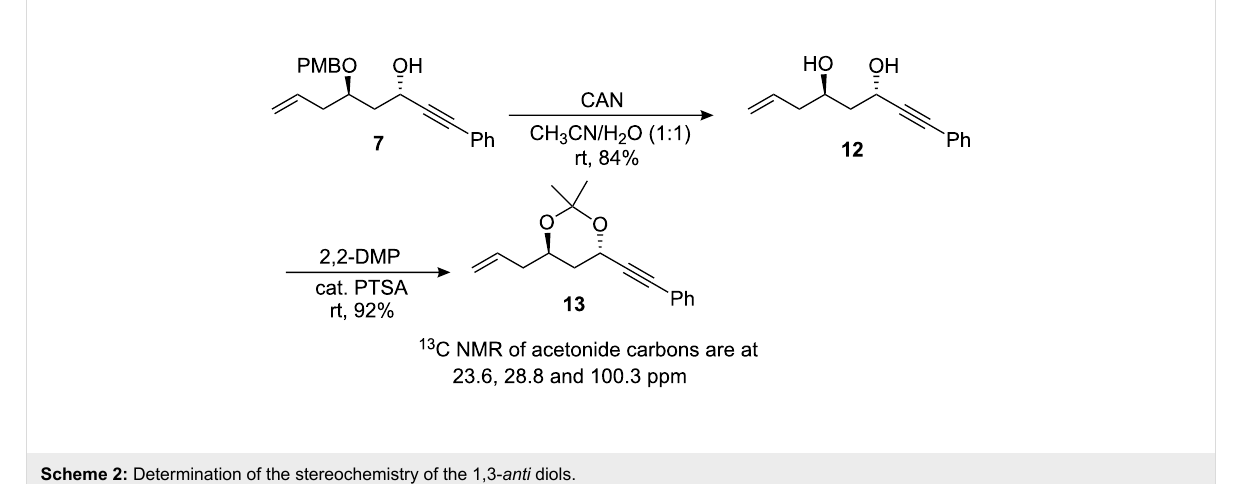
Scheme 2: Determination of the stereochemistry of the 1,3- anti diols.